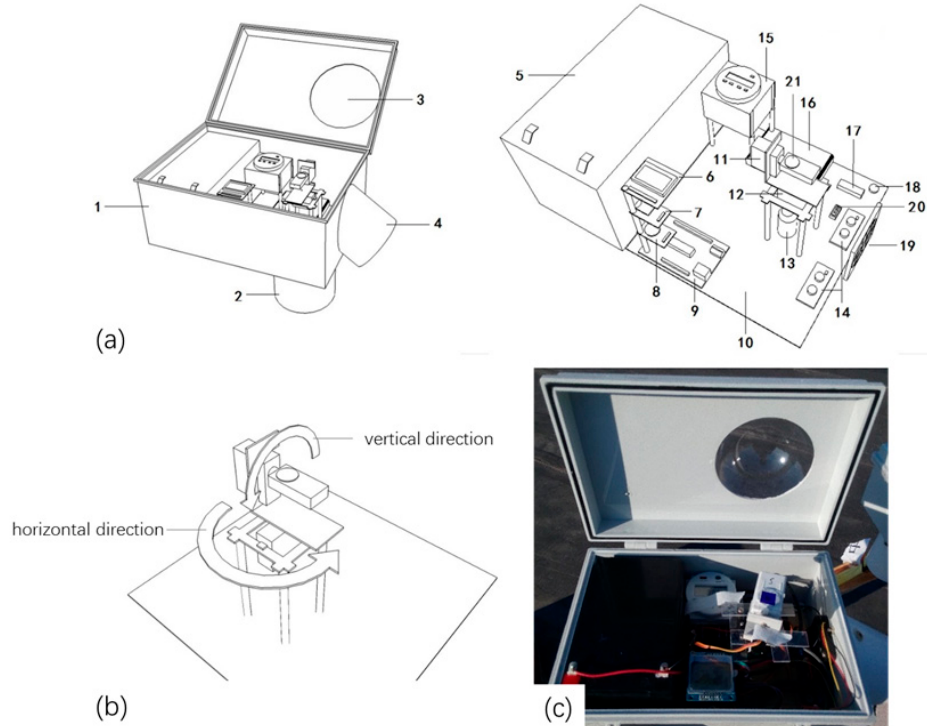
Figure 1. AHS design drawing and physical drawing: ( a ) The diagram of the AHS with all components labeled. ( b ) Schematic of obtaining data from multiple directions; the horizontal and vertical arrows indicate the direction of rotation of the servomotors. ( c ) A photos of the AHS in the field test. (1) Waterproof case of instrument, (2) waterproof case of temperature/humidity sensor, (3) high anti-reflecting hemispherical shell, (4) waterproof radiator, (5) the accumulator battery, (6) the screen module, (7) the SD card module, (8) the clock module, (9) Arduino UNO R3, (10) the waterproof layer, (11) vertical rotary servomotor, (12) horizontal rotary servomotor, (13) temperature/humidity sensor, (14) power converter (step-down voltage regulator), (15) timer, (16) solar charge controller, (17) FUSE, (18) AMD standard aviation plugs connected with solar panel, (19) ventilating fan, (20) push switch, (21) the ambient light sensor with low-pass filter.